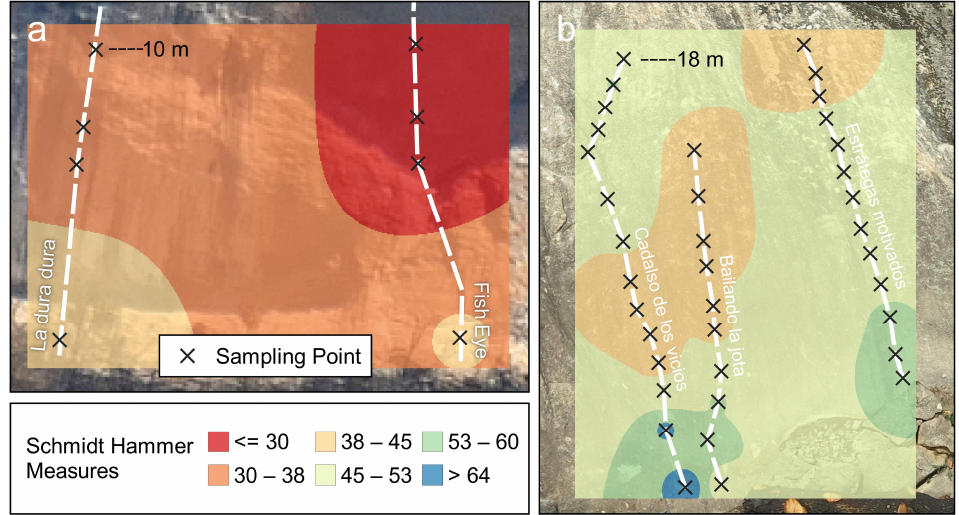
Figure 12. Spatial distribution of the SH measurements in: ( a ) “La Dura Dura” (Oliana) and ( b ) three routes in Site 6 of Cadalso de los